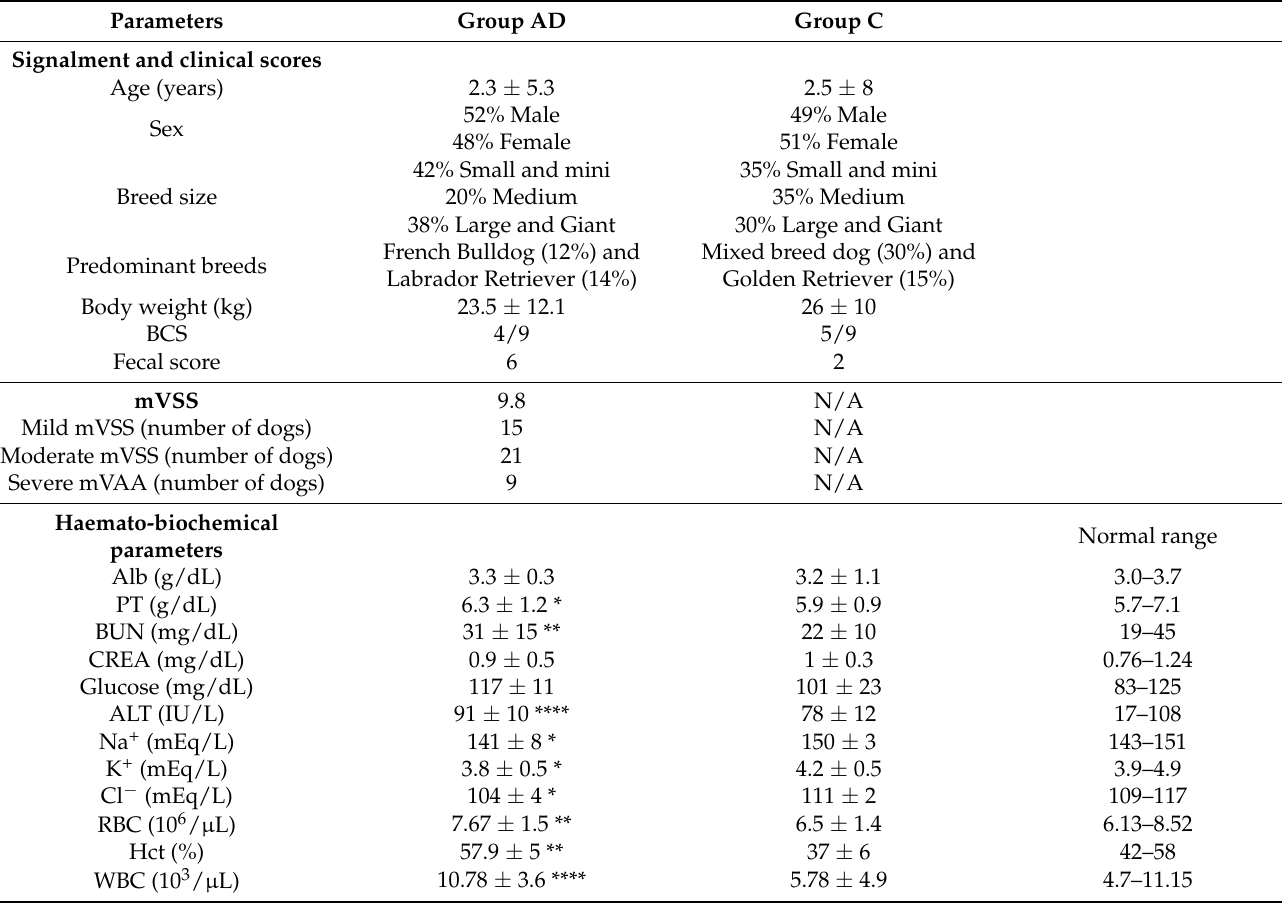
Table 2. Demographics and baseline characteristics of Group AD and